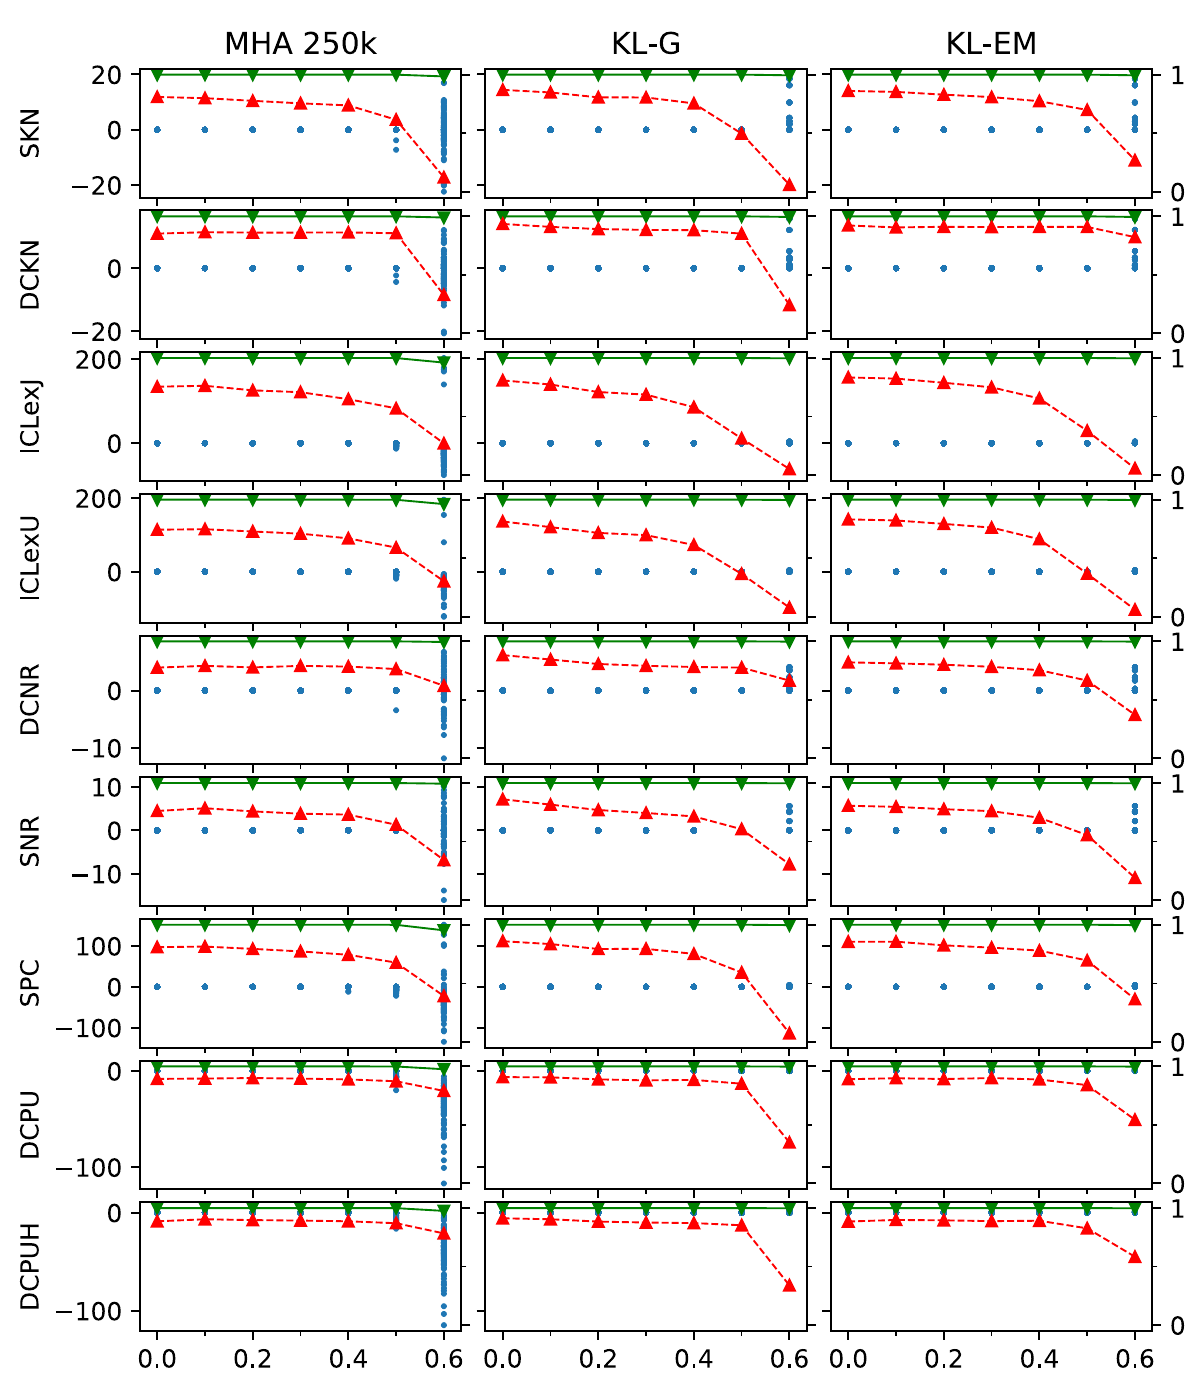
Fig 14. Executing the inference algorithms from the true partition 10 times for 10 network instances for each μ benchmark. The Figure is structured in the same way like Fig 6. The resulting difference to the original value (designated with a blue dot ● ), the average AMI of all runs of all network with the same parameter (represented with green triangles upside down ▼ ) and for comparison the average of the results from a random starting partition with the known number of groups (designated with red triangles ▲ ) are shown. The AMI values of each row are visualized according to the right axis of each row. The difference between the objective function values we calculate with P observed − P true and is measured according to the left axis in each